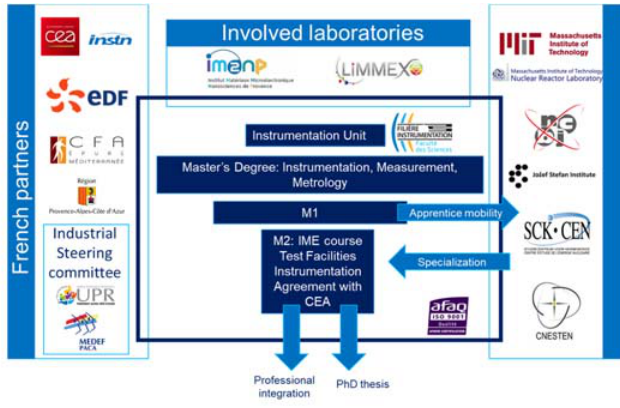
Fig. 4. Diagram of the MOBIL-APP project consortium These partners were chosen and contacted because (except for the CFA) they are major research or industrial players in the nuclear energy sector or emergent player. They are involved in high level research works or research and development activities. They possess different and interesting kinds of nuclear facilities requiring dedicated instrumentation and measurement